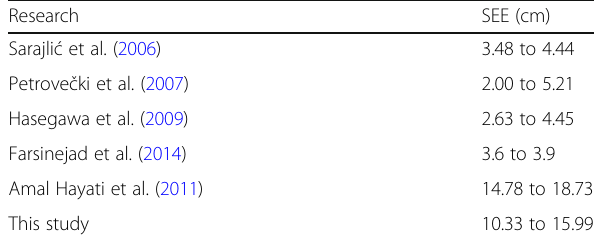
Table 5 Comparison of Standard Error of Estimate (SEE) with other similar studies using x-ray on long